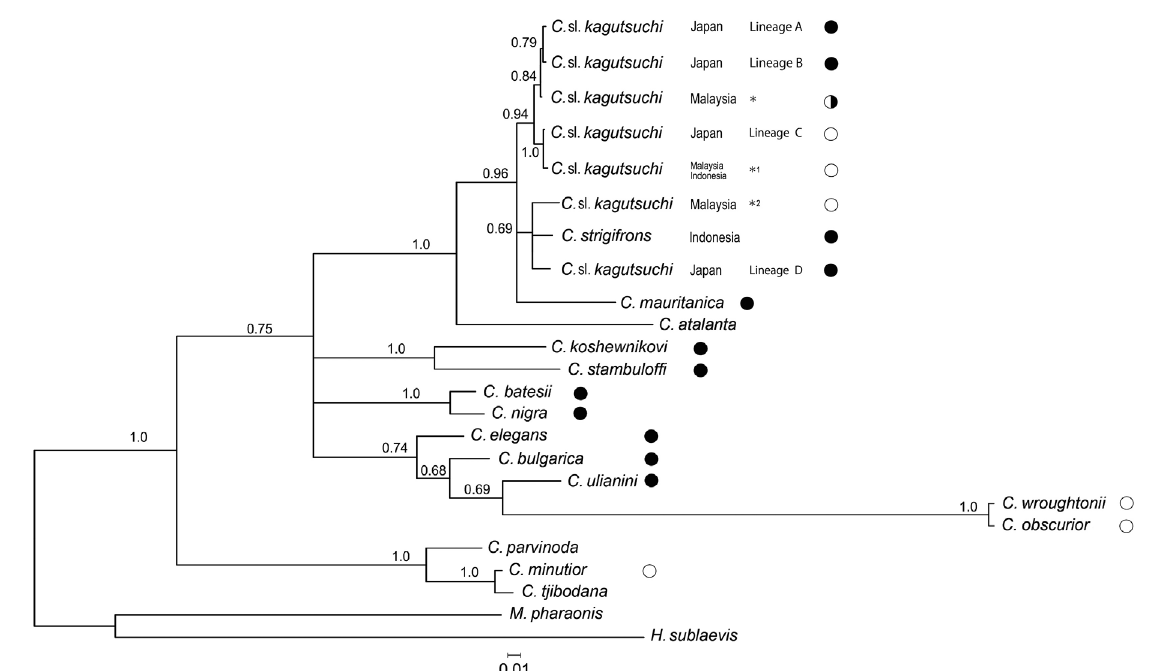
Fig 3. Majority rule consensus tree based on the mitochondrial COI/II genes (829 bp) of the ant genus Cardiocondyla and two other genera from Bayesian analysis (1,000,000 generations). The posterior probabilities are shown at the node. The genera names are as follows: C — Cardiocondyla ,